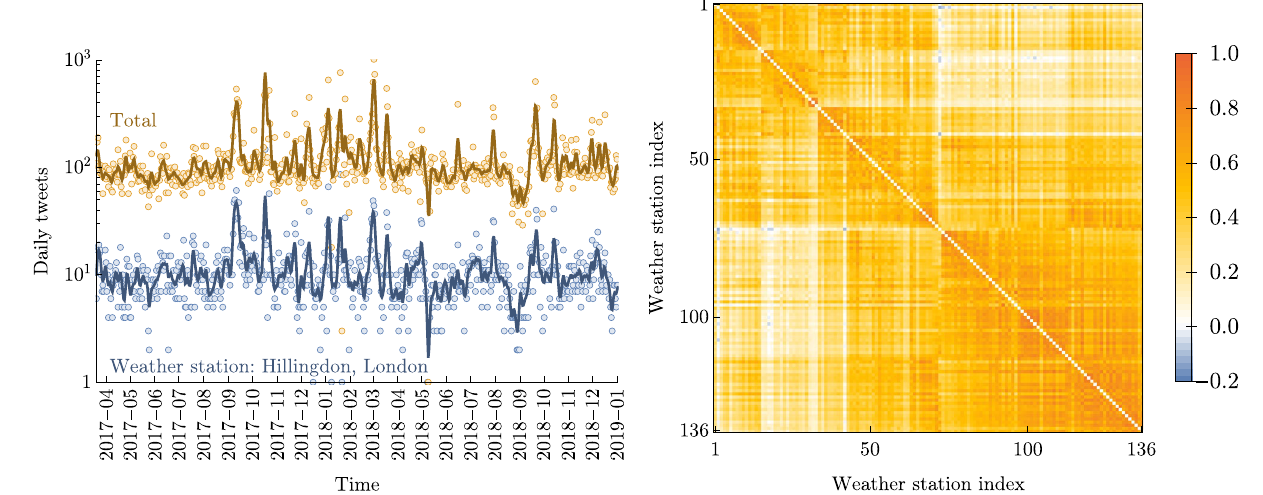
Figure 4. Local-national correlations in tweet volumes and wind speeds. Left panel : Daily tweet volumes for the whole UK (total number of tweets within 50 km of any UK Met Office weather station; yellow) and local to the single highest-volume weather station (Northolt, London; blue). Points show daily counts while the 7-day moving average is shown with solid lines. There is substantial temporal variability in both time series. The two time series are strongly correlated (see text). Right panel: Pairwise Spearman’s rank correlations for wind speed timeseries for all weather stations. Strong positive correlations are seen for almost all weather station pairs, though the strength the correlation is variable. This indicates a high level of local-national correlation in wind